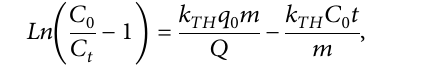
Table 1: Physical properties of the prepared activated carbon deduced from N Surface area (m 2